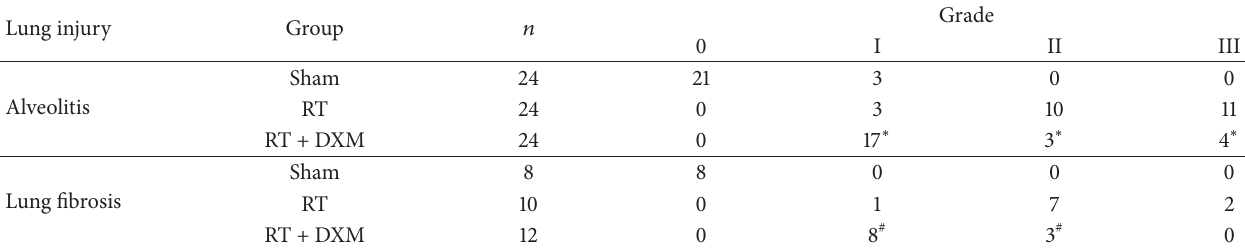
Table 2: Comparison of the pathology grade of alveolitis and pulmonary fibrosis.